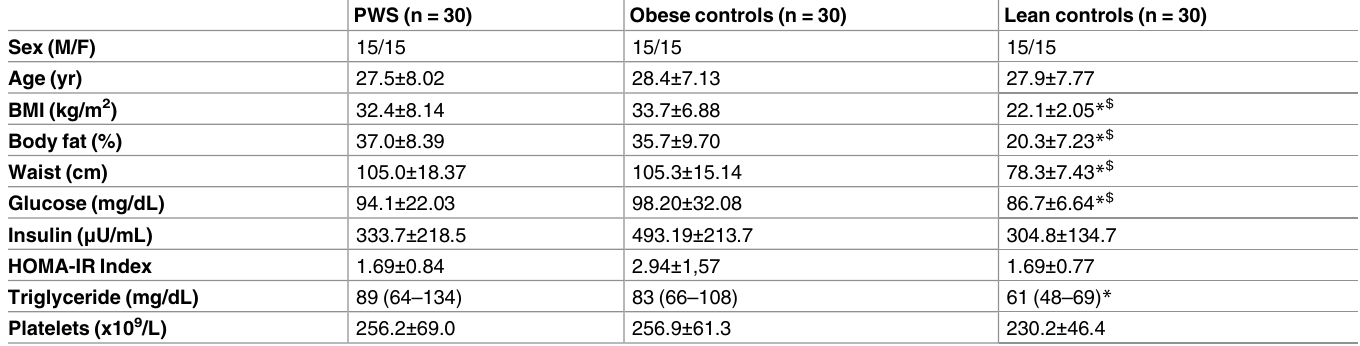
Table 1. Baseline characteristics of all